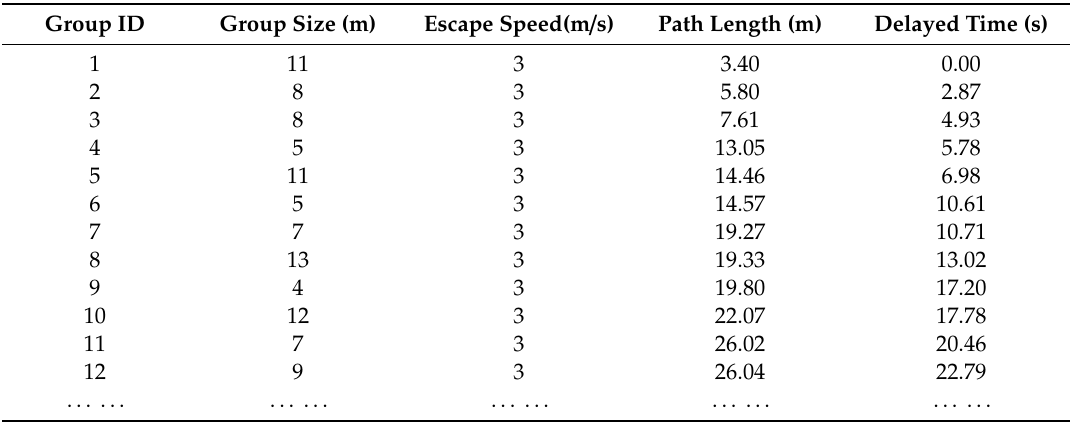
Table 4. The relationship of the evacuation path length and the delayed departure time of some groups planned by the PSEP algorithm when evacuation density is large.